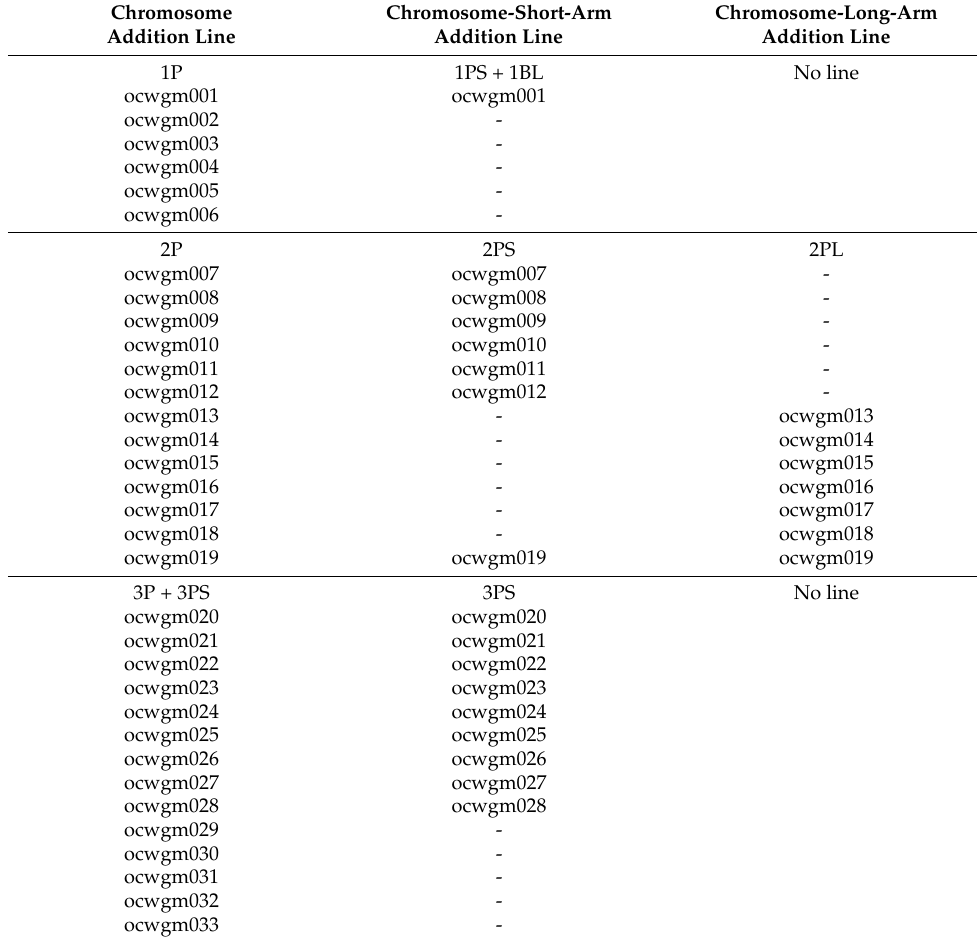
Table 2. The most accurate locations of specific SSR markers established with Agropyron addition lines. Chromosome Addition